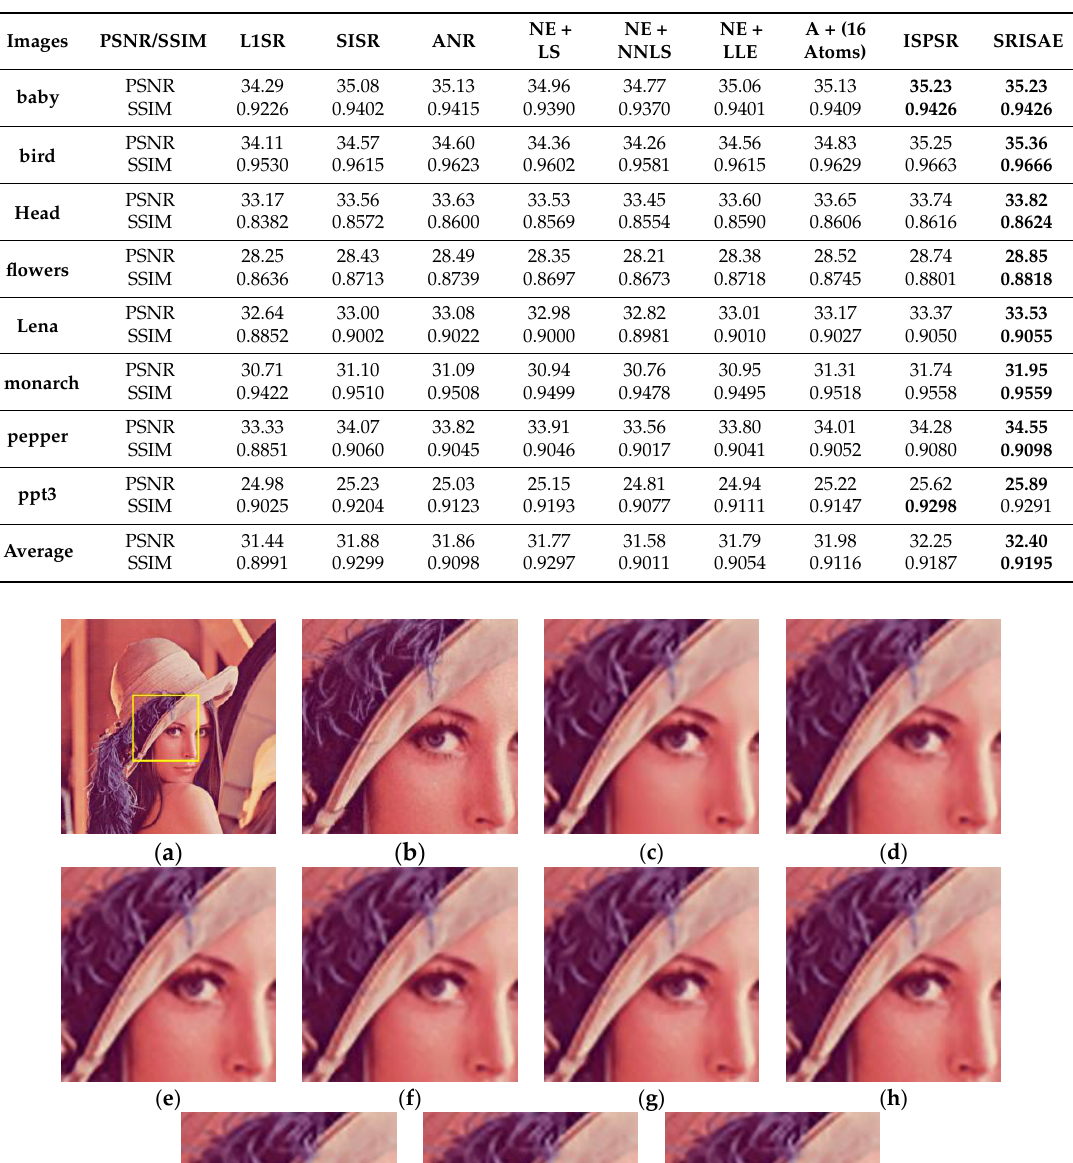
Table 3. Comparison of the PSNR and the SSIM of the reconstructed images with different SR algorithms (PSNR/SSIM).